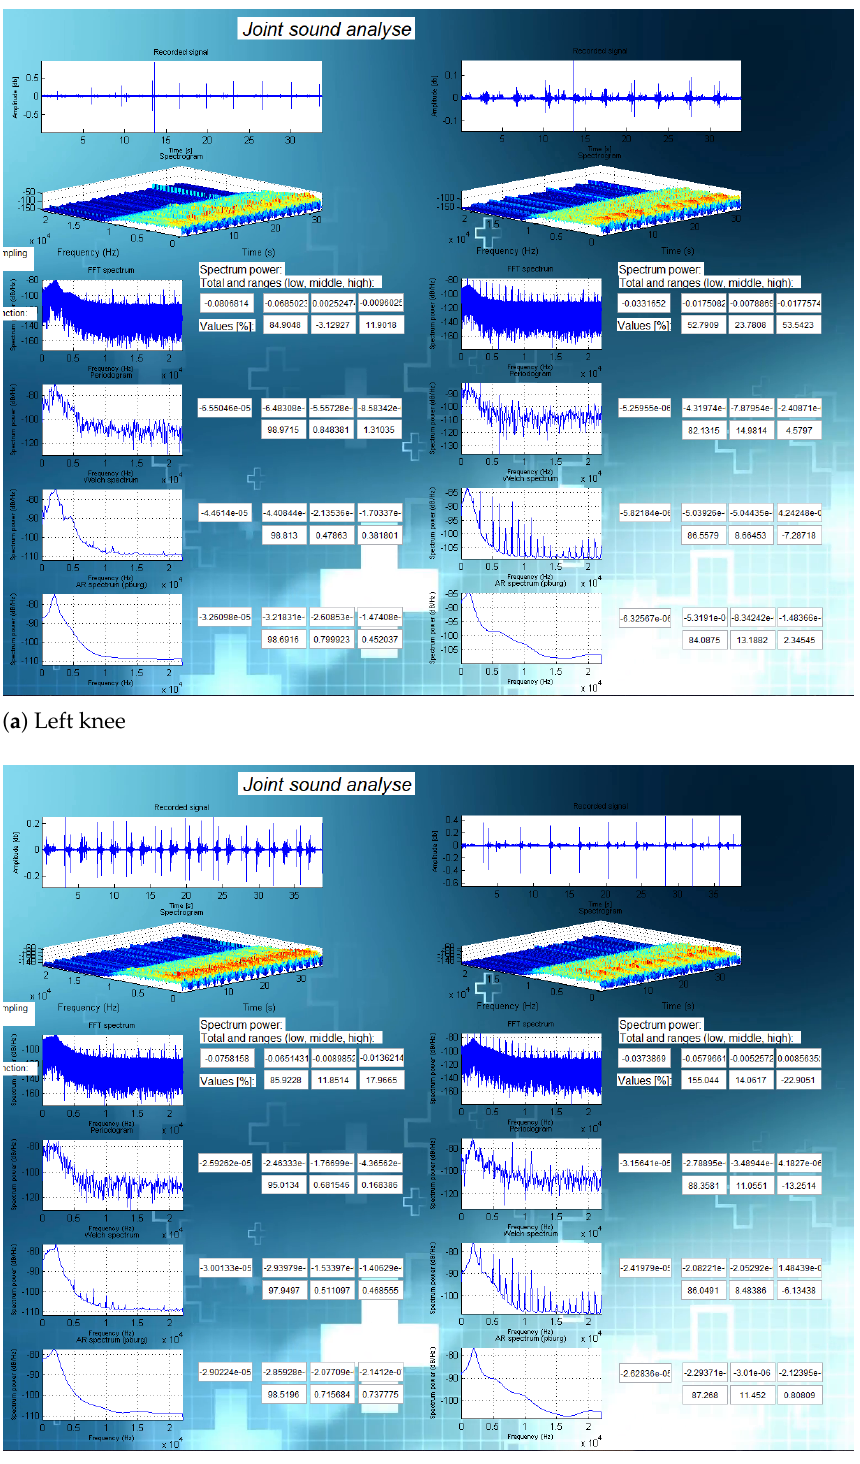
Figure 9. Analysis for an older person (subject